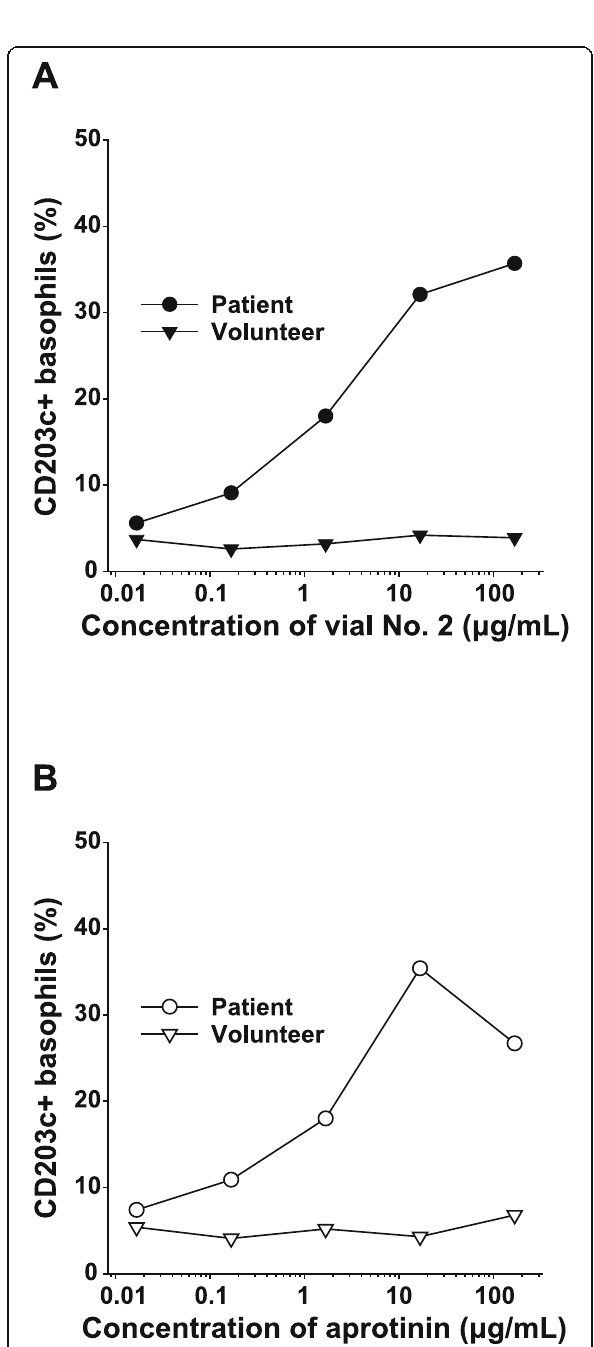
Fig. 2 Results of basophil activation tests for CD203c. A Vial no. 2 induced CD203c upregulation in the patient but not in the volunteer. B Aprotinin induced CD203c upregulation in the patient but not in the